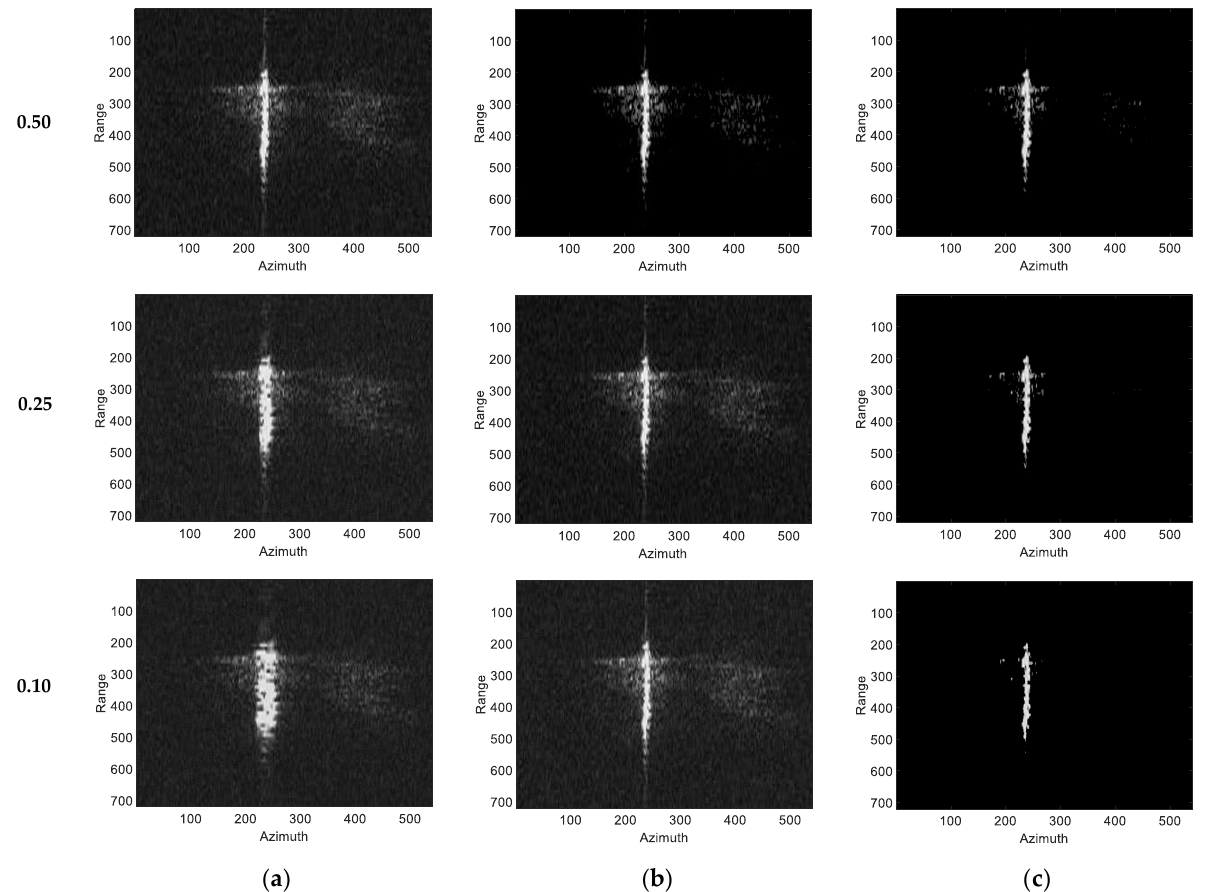
Figure 10. Imaging result of ship 2 from GF-3 measured data with different methods. ( a ) Imaging results of the method in [8]; ( b ) Imaging results of the method in [17]; ( c ) Imaging results of the proposed method. Table 2. Evaluation of measured experiments.